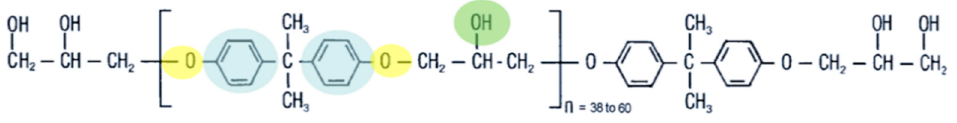
Figure 1. Polymer structure of phenoxy.